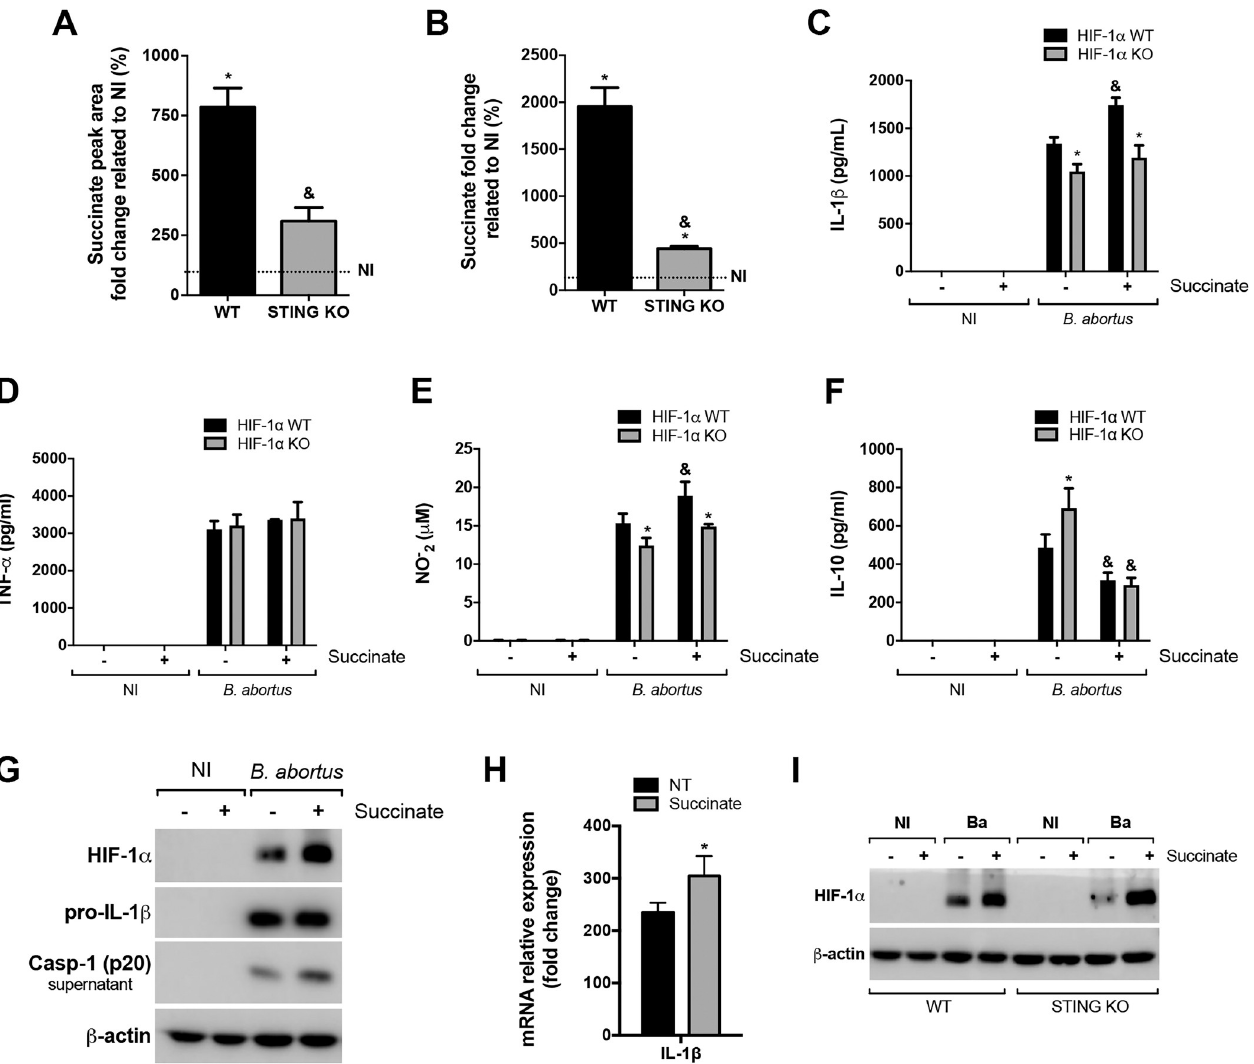
Fig 5. STING increases the intracellular succinate concentration that leads to HIF-1 α stabilization and IL-1 β release. Measurements of intracellular succinate levels by (A) liquid chromatography-mass spectrometry and by (B) Succinate Colorimetric Assay Kit in B . abortus -infected macrophages derived from C57BL/6 (WT) and STING KO mice. IL-1 β (C) , TNF- α (D) and IL-10 (F) produced by macrophages derived from HIF-1 α WT and HIF-1 α KO mice, pretreated or not with succinate (5 mM) and then non-infected (NI) or infected with B . abortus , detected in cell supernatants using ELISA. (E) NO 2 − (nitrite) accumulation in the media of macrophages derived from HIF-1 α WT and HIF-1 α KO mice, pretreated or not with succinate (5 mM) and then non-infected (NI) or infected with B . abortus , measured by Griess reaction. (G) Western blot analysis of HIF-1 α and pro-IL-1 β in cell lysates and caspase-1 (p20 subunit) in supernatants from macrophages derived from C57BL/6 (WT) mice, pretreated or not with succinate (5 mM) and then non-infected (NI) or infected with B . abortus . Equal loading was controlled by measuring β -actin in the corresponding cell lysates. (H) IL-1 β expression levels determined by real-time RT-PCR in B . abortus -infected macrophages derived from C57BL/6 (WT) mice, non-treated (NT) or pretreated with succinate (5 mM). (I) Western blot analysis of HIF- 1 α in cell lysates from C57BL/6 (WT) and STING KO mice, pretreated or not with succinate (5 mM) and then non-infected (NI) or infected with B . abortus (Ba). Equal loading was controlled by measuring β -actin in the corresponding cell lysates. The data (A-I) are representative of three independent experiments. The data (A and B) are presented as mean ± SD, & (comparison between WT and KO) or � [comparison between non-infected (NI, set to 100%) and infected], p < 0.05, one-way ANOVA. The data (C-F) are presented as mean ± SD, � (comparison between WT and KO) or & (comparison between non-treated and succinate-treated), p < 0.05, two-way ANOVA. The data (H) is presented as mean ± SD, � p < 0.05, Student’s t